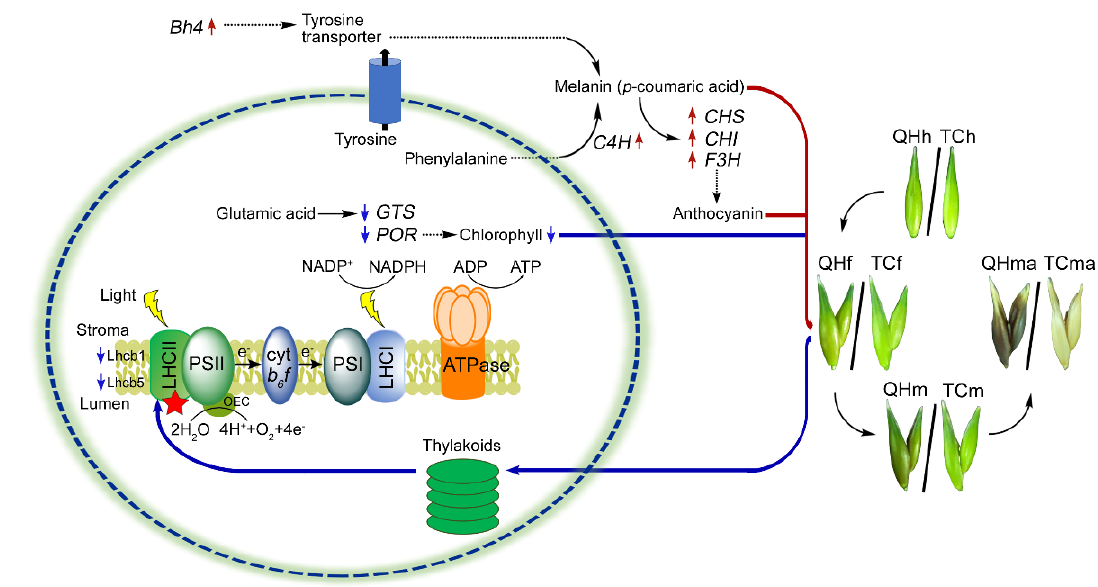
Figure 7. A molecular regulatory scheme of photosynthesis in response to color changes at the flowering stage. The dotted line indicates that the process is unknown, or some steps are omitted. The red and blue arrows indicate up- and downregulation, respectively. Red stars indicate LHCII which are impaired at flowering stage.